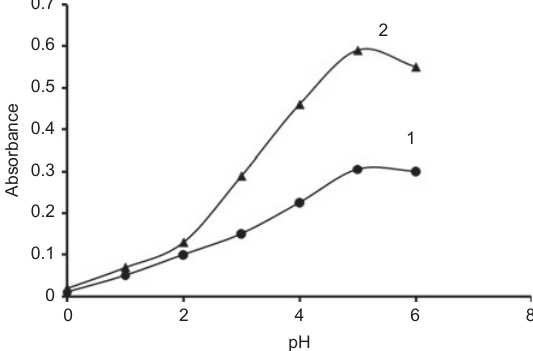
Figure 2 Color development of the Rh(III)-NRS complex in solu- tion (1) and resin phase (2) as function of pH.